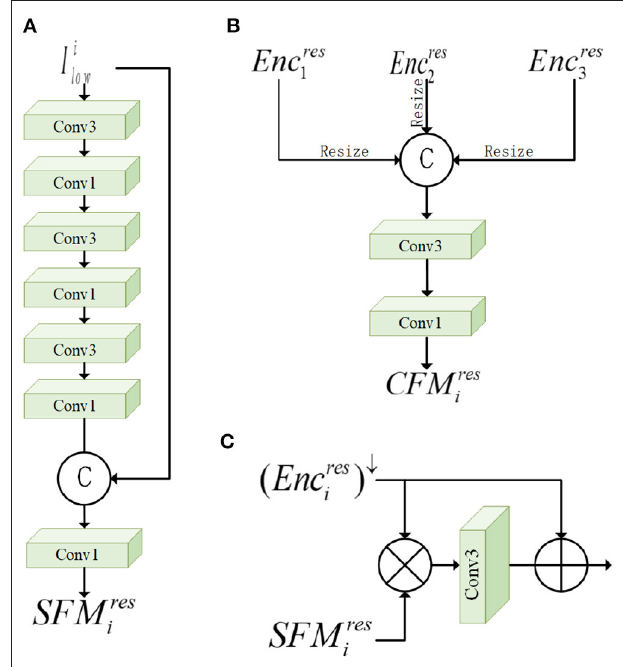
FIGURE 3 | The various sub-modules of the network: (A) Shallow feature module (SFM), (B) cascade fusion module (CFM), and (C) feature enhancement module